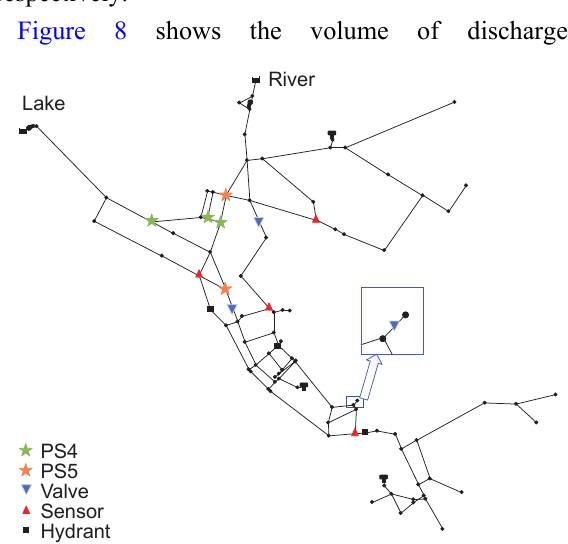
Fig. 7 Multiple pollution events PS4 and PS5.